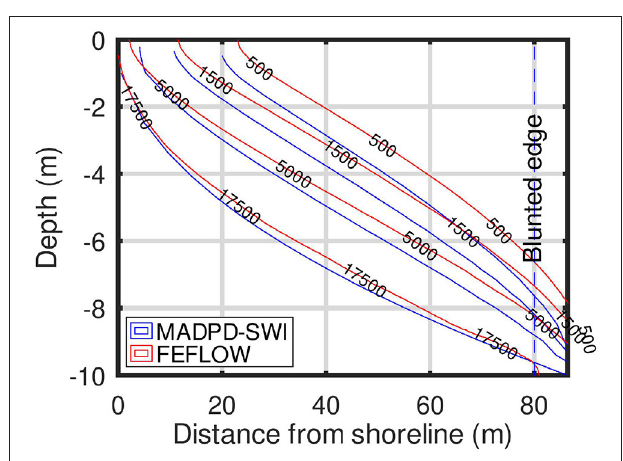
FIGURE 4 | Lines of constant salinity [ppm TDS] of the FEFLOW and 2D-MADPD-SWI solutions for α =